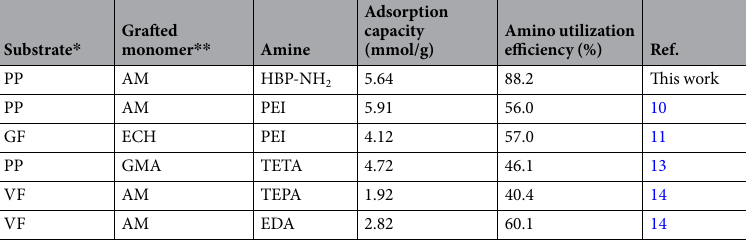
Table 3. Comparison of CO 2 adsorption capacity of amine functionalized fibrous sorbents (adsorption temperature: 25 °C, CO 2 concentration: 10%). * GF: glass fibers, VF: viscose fibers, ** ECH: epichlorohydrin, GMA: glycidyl methacrylate.